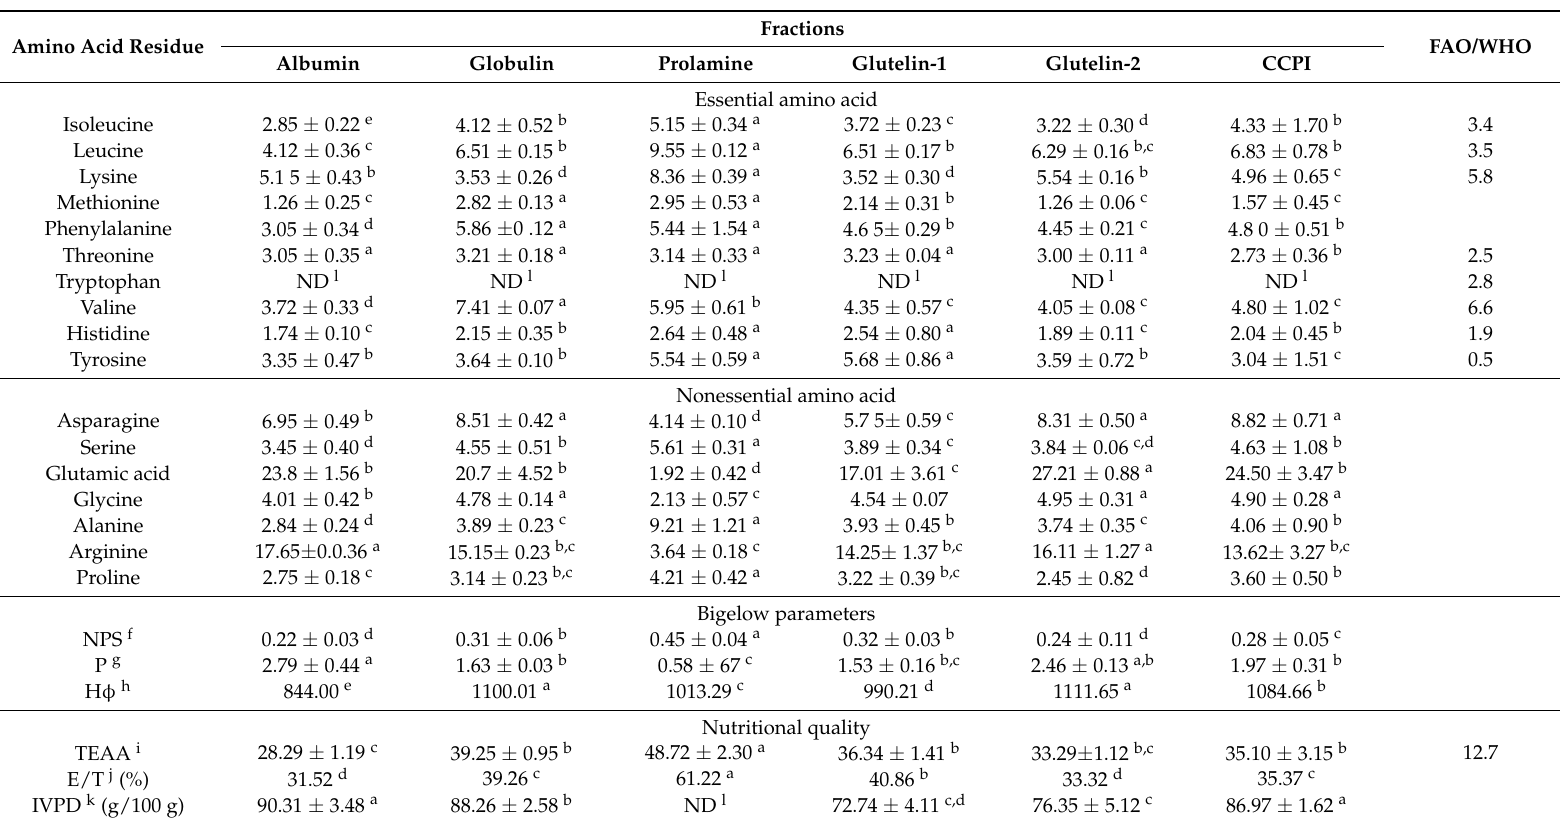
Table 1. Amino acid composition (g/100 g protein), Bigelow parameters and nutritional quality of coconut cake protein fractions and coconut cake protein isolates